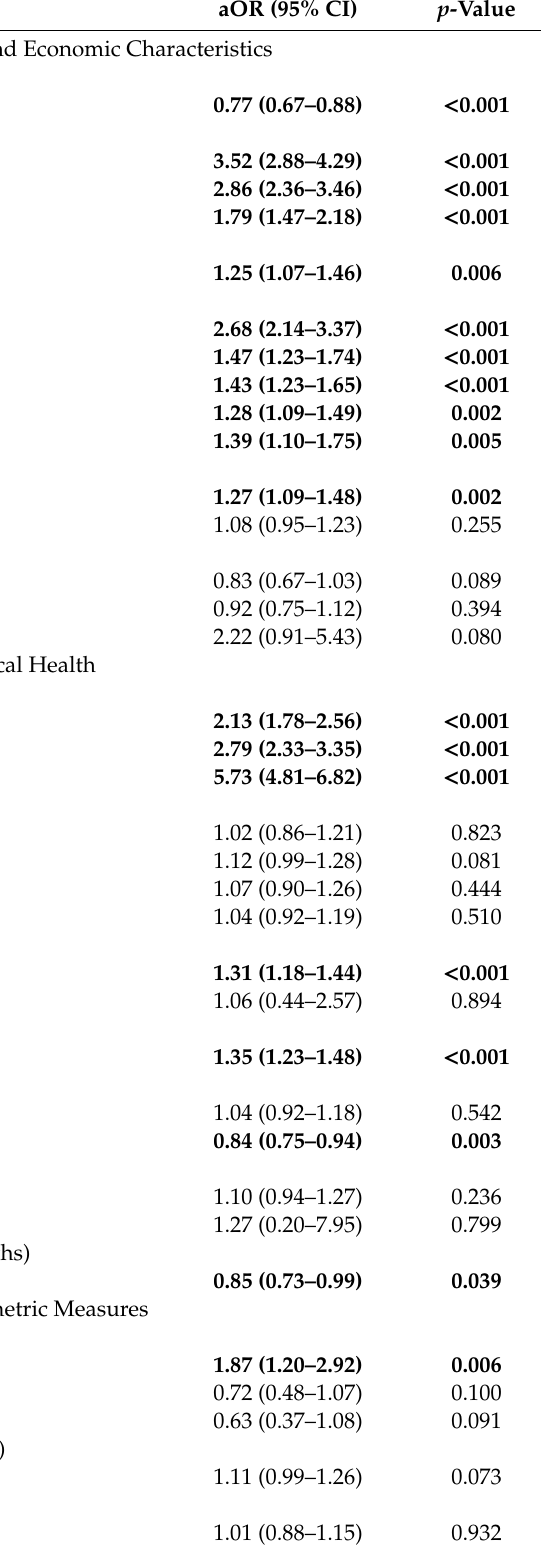
Table 2. Adjusted odds ratios of anxiety disorders by immigrant status, socio-demographic, physical health, health behavior, over- and under-nutrition, and dietary measures (Model 7). Variable aOR (95% CI) p -Value Demographic, Social, and Economic